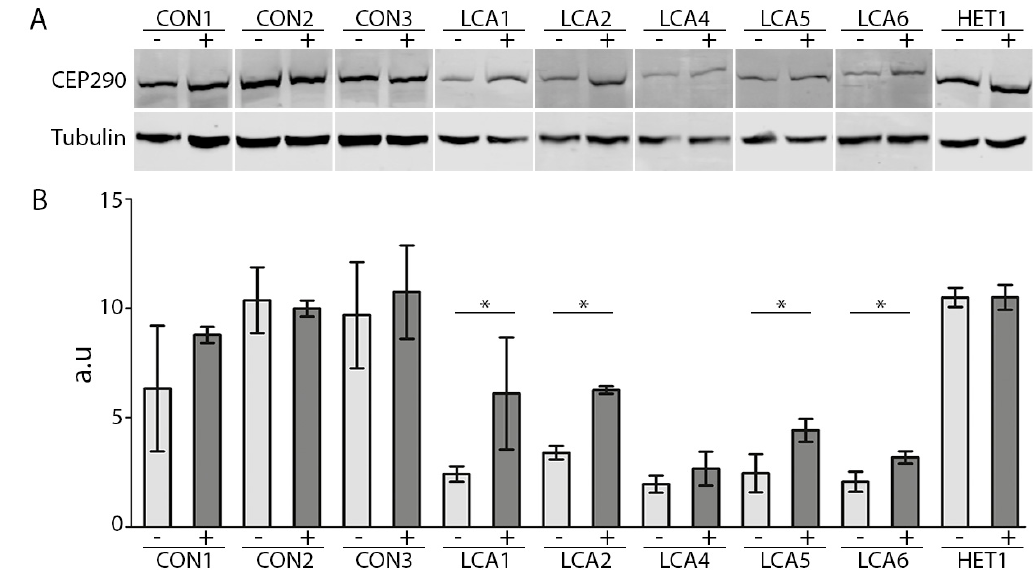
Figure 2. CEP290 protein levels upon AON delivery. ( A ) Immunodetection of CEP290 protein (upper panel) and Tubulin (lower panel) in all controls (CON), LCA-affected patients (LCA) and carrier (HET), in the presence (+) or absence ( − ) of AON. Tubulin was used as loading control; ( B ) Quantification of the CEP290 protein levels using Fiji software. Bands were quantified twice for each replicate and normalized to Tubulin. Results show the average value for the intensity of the bands and the error bars indicate the standard deviation. The asterisk (*) indicates statistically significant differences ( p -value < 0.05 using Mann-Whitney test).